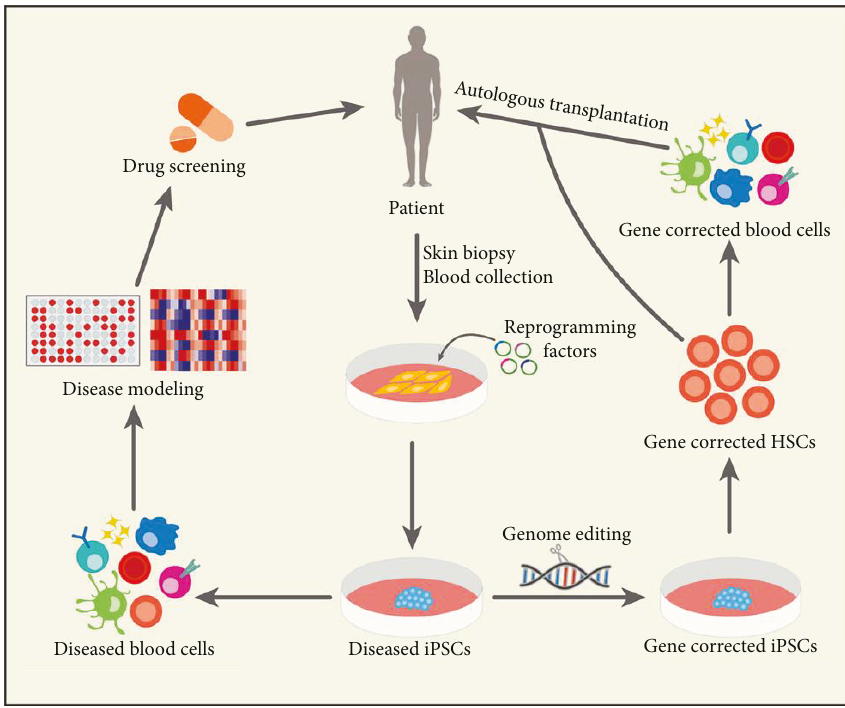
Figure 1: Applications of iPSCs for disease modeling and autologous cell-based therapy. Disease-speci fi c iPSCs can be generated from patients with inherited blood diseases. A panel of disease-speci fi c iPSCs and their derivatives enable high-throughput screening assay against the library of hundreds of thousand compounds. This approach represents a powerful tool for elucidating disease mechanisms and developing new drugs. Alternatively, the genome editing technology can be employed to correct genetic mutations followed by directed di ff erentiation; the gene-corrected iPSC-derived hematopoietic stem cells (HSCs) or other mature blood cells can be transplanted or transfused to the same